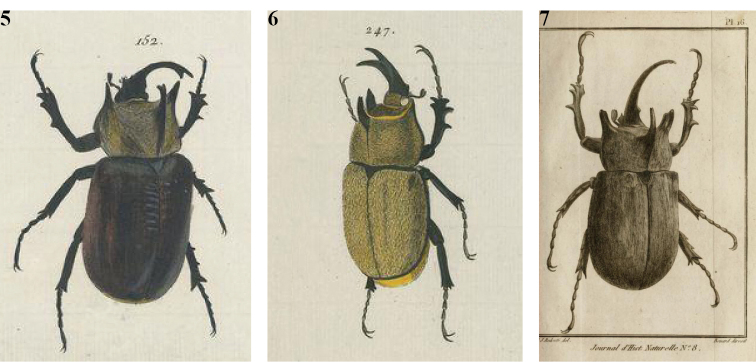
5 G-A Olivier 1789. “Entomologie ou Histoire Naturelle des Insectes”, Tav. XVI fig. 252. Scarabaeus
typhon6 G-A Olivier 1789. “Entomologie ou Histoire Naturelle des Insectes”, Tav. XXVIII fig 247. Scarabaeus
laniger7 G-A Olivier 1792. “Journal d’Histoire Naturelle”, no. 8. Scarabaeus
entellus